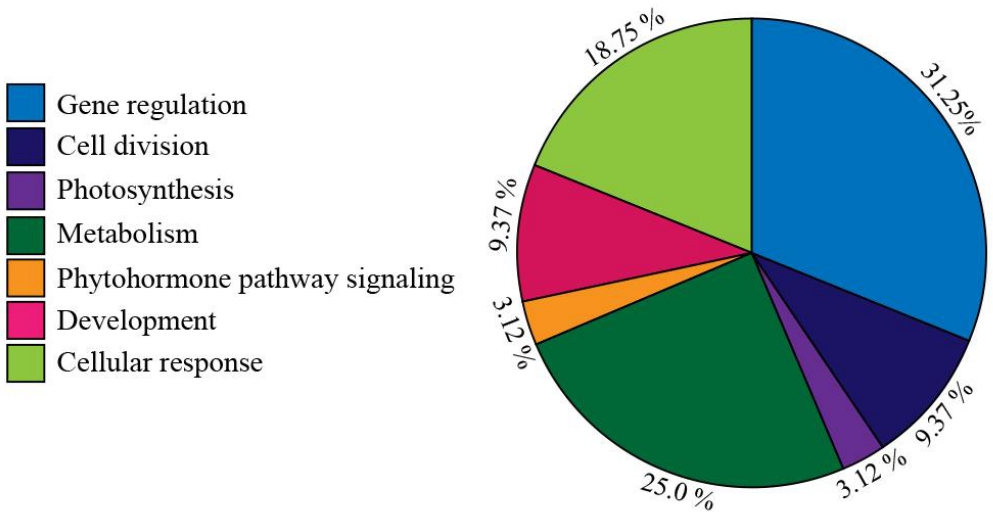
Figure 3. Functional protein categories of P. calyculatus infective stages. Pie chart illustrating the major functional proteins. Table 1. Proteins detected in Psittacanthus calyculatus infective stages.